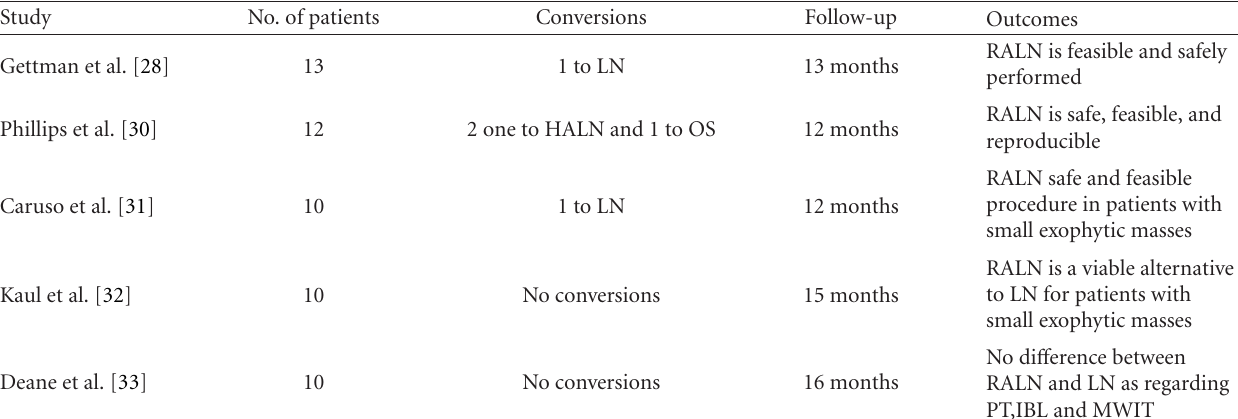
Table 3: Studies for robotic-assisted laparoscopic